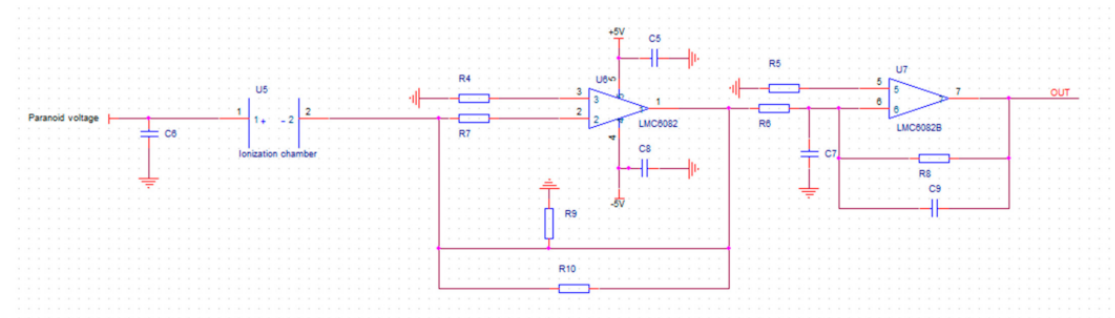
Figure 8. The schematic diagram of the readout